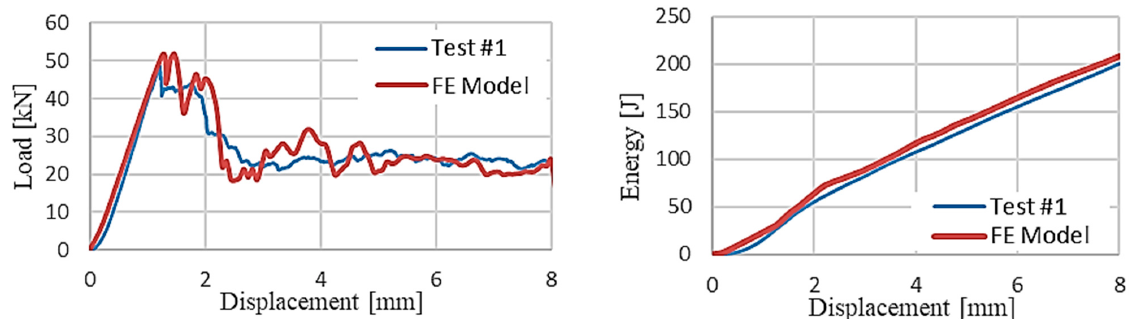
Figure 18. Comparison of the FE model (with a plug-initiator) with experimental tests: load-dis- placement curves ( left ) and energy curves ( right ) of the sinusoidal with 5 curvatures.